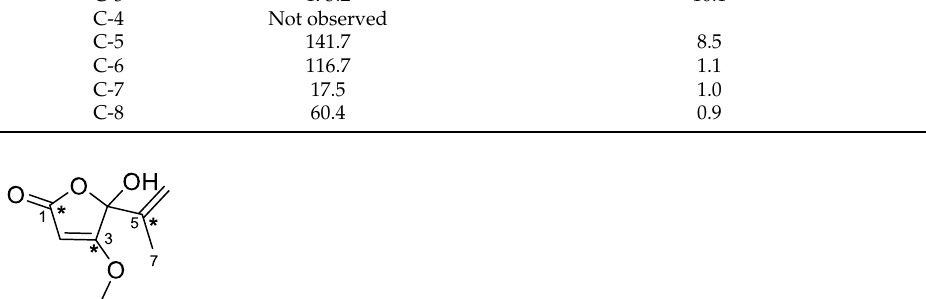
Figure 5. Labelling pattern observed in 13 C NMR spectrum of penicillic acid ( 1 ) produced by cultures supplemented with 1- 13 C sodium acetate. supplemented with 1- 13 C sodium